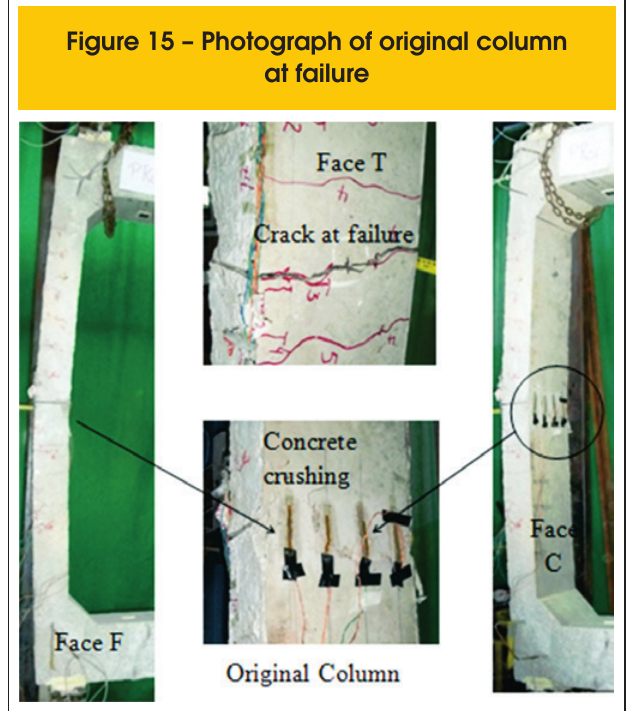
Figure 15 – Photograph of original column at failure